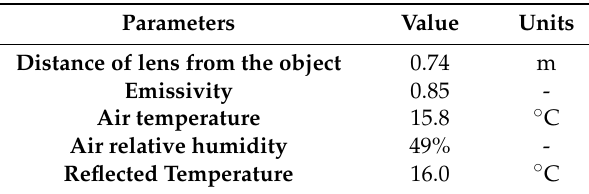
Table 2. Parameters defined for the thermography survey.